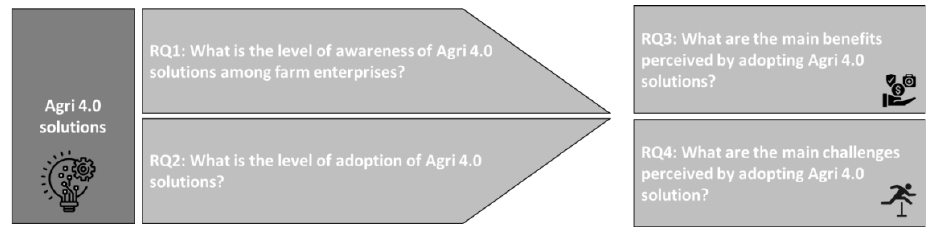
Figure 1. Reference